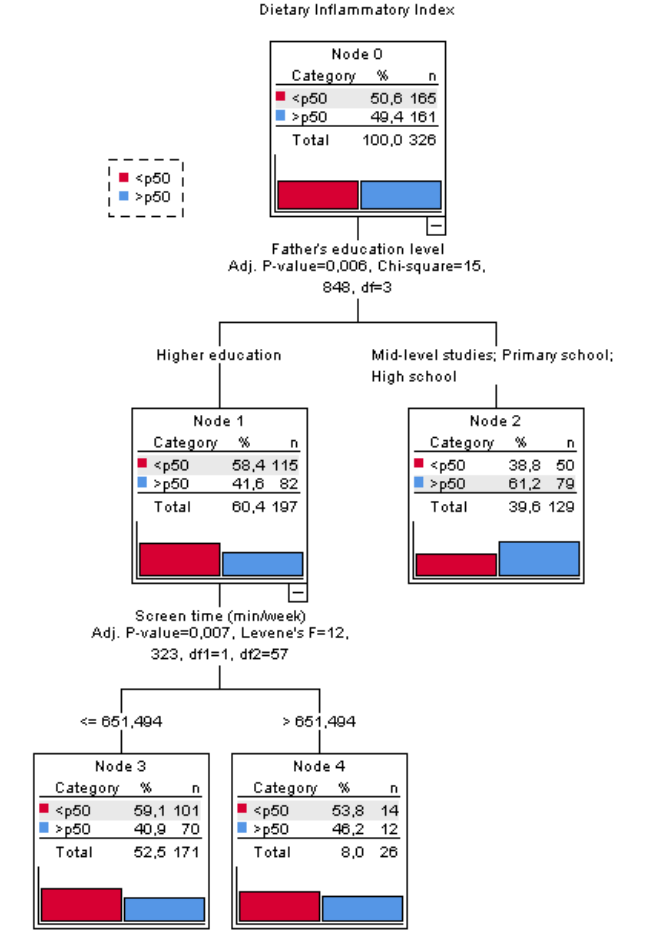
Figure 1. Decision tree based on the dietary inflammatory index above or below the median, father’s level of education (higher or secondary, middle, and primary), and total screen time below or above 651.5 min/week.